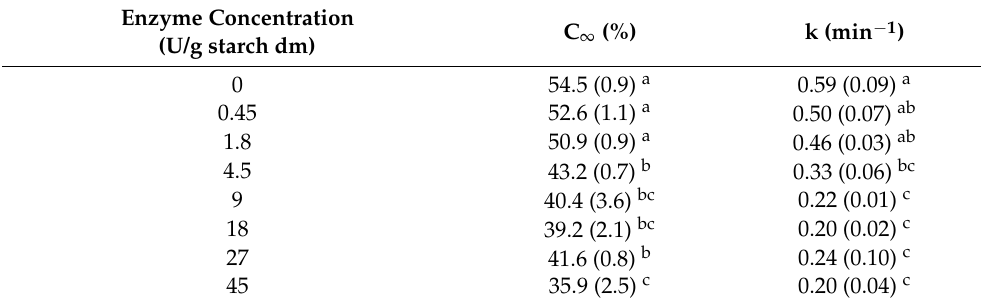
Table 2. Kinetic parameters (C ∞ and k) obtained by fitting the experimental data on first-order kinetics for the starches modified by different dosages of amylomaltase (AMM) (U/g starch dm) during rapid visco analysis (RVA) and subsequently stored at 5 ◦ C for 24